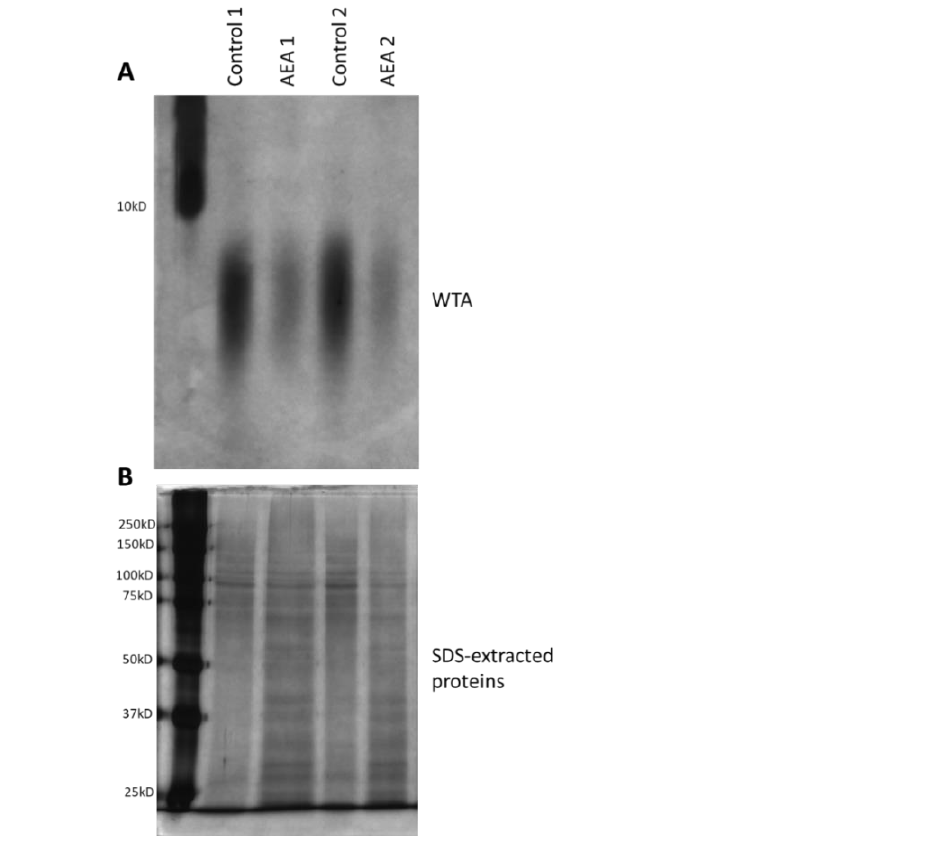
Figure 6. AEA reduces the cell wall content of wall teichoic acid (WTA). ( A ). MDRSA CI-M was incubated in the absence or presence of 50 µg/mL AEA for 2 h, and the WTA content analyzed on a 20% PAGE followed by Alcian blue–silver staining. Duplicate samples are presented. ( B ). Silver staining of SDS-extracted proteins run on a 10% SDS-PAGE from the same samples as in ( A ), but from a processing step prior to WTA isolation.